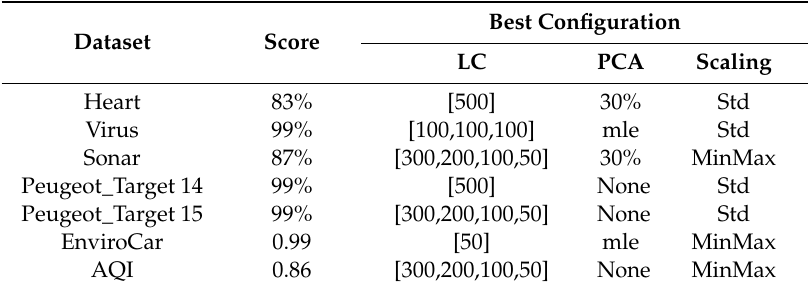
Table 30. ReLU activation function results.